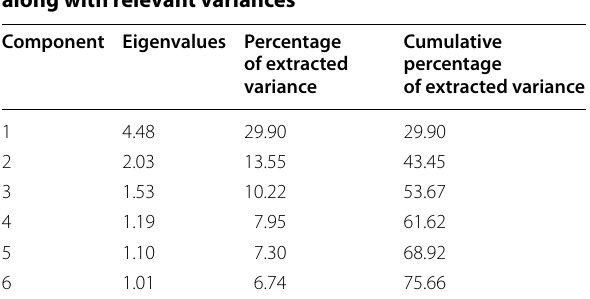
Table 2 Factor loadings and T values